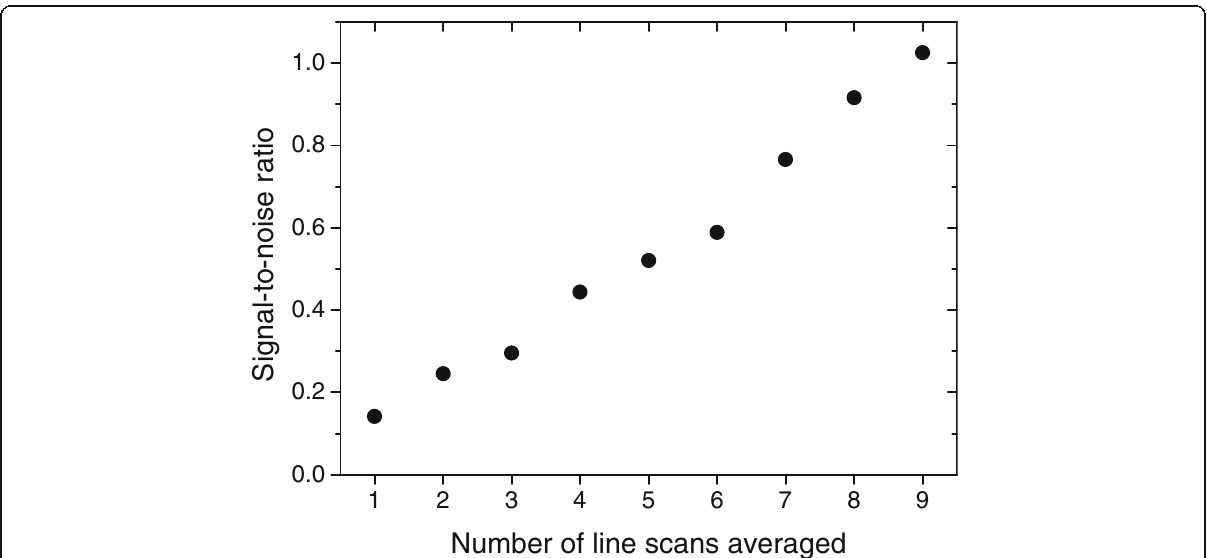
Fig. 5 Signal-to-noise ratio values with respect to the corresponding numbers of line scans averaged. The signal intensities were taken for the Se emission peak at 203.93 nm, and the noise values were estimated from the baseline intensities nearby the Se emission peak (see